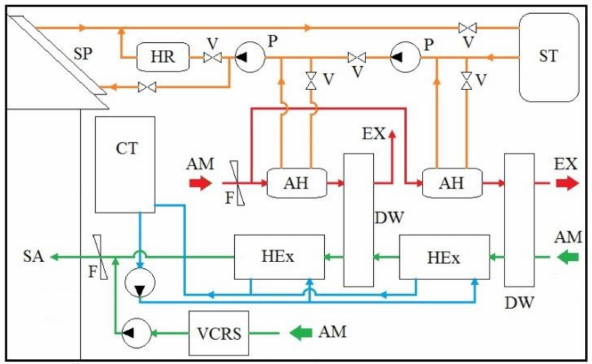
Figure 11. Schematic diagram of Solar hybrid desiccant air-conditioning